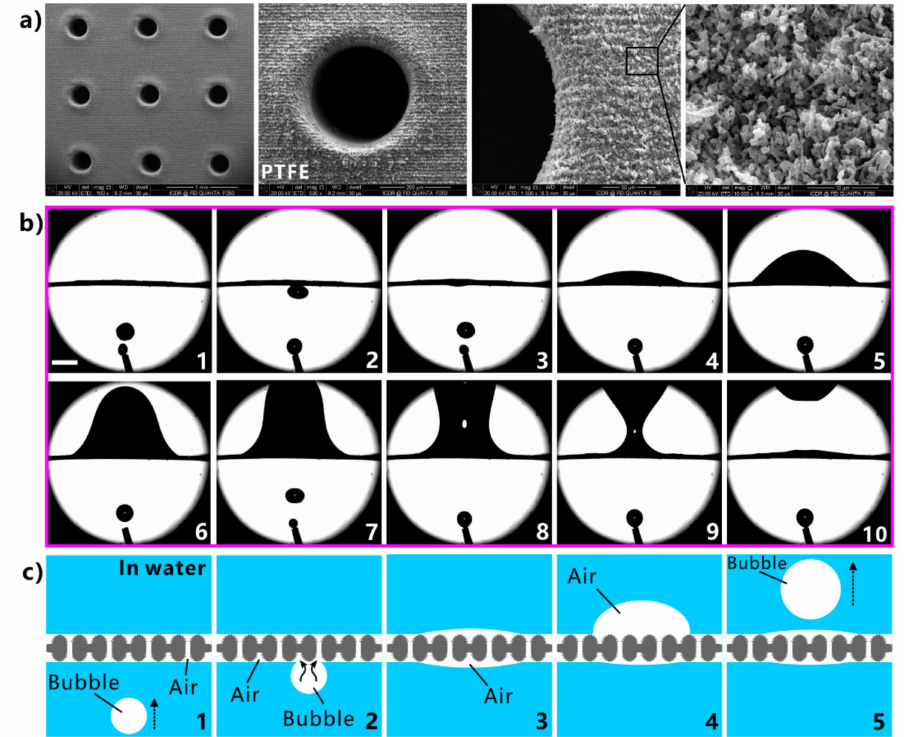
Figure 28. Ability of bubbles passing through an underwater superaerophilic porous sheet in water. ( a ) Morphology of the superaerophilic porous PTFE sheet. ( b ) Process of continuously releasing bubbles below the porous sheet underwater. ( c ) Schematic mechanism of the passage of the bubbles through the underwater superaerophilic porous sheet in water. Reprinted with permission from ref. [46]. Copyright 2017, American Chemical